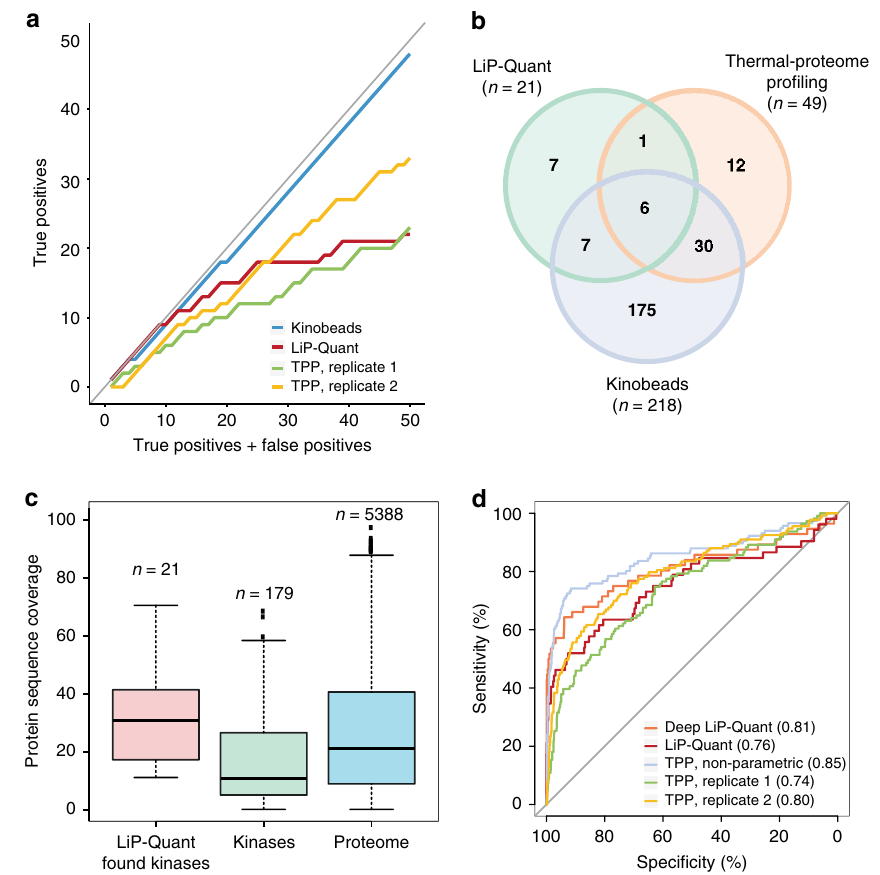
Fig. 2 Benchmarking the LiP-Quant approach. a True positive rate evaluation for selected assays (LiP-Quant, thermal proteome pro fi ling (TPP) and kinobeads) focused on kinase target identi fi cation for staurosporine 6,23 . True positive hits in the top 50 candidates (see Methods section) are shown as a function of the number of true and false positives in the candidate list for the respective assays. Since staurosporine is a promiscuous binder of protein kinases, we considered the entire protein kinase space as the reference for true positive identi fi cations. The gray line indicates a perfect candidate list containing only true positives (slope = 1). b Total number of kinase targets, as well as common kinase targets of staurosporine found in the LiP-Quant, TPP and kinobeads experiments. c Distribution of protein sequence coverage for kinases identi fi ed by LiP-Quant (pink, n = 21), all quanti fi ed protein kinases by MS in HeLa cells (green, n = 179) and the entire measured proteome (blue, n = 5388). In the box plots the central line de fi nes the median, the bounds of box the fi rst and third quartile, the whiskers are the minimal and maximum values. d Receiver operating characteristic (ROC) curves of staurosporine protein interactions measured by three different chemoproteomics methods. The ROC curve of LiP-Quant (red) is compared with that of two replicates of TPP experiments based on melting point fi ttings (green and yellow), a non-parametric analysis of whole TPP dose – response curves (cyan) and LiP-Quant with a LC-MS gradient of 4 h (Deep LiP-Quant). Bracketed numbers represent areas under the curves (AUC). The gray line represents a random classi fi er. The ground truth is represented by the 512 protein kinases present in the human genome. Source data are provided as a Source Data